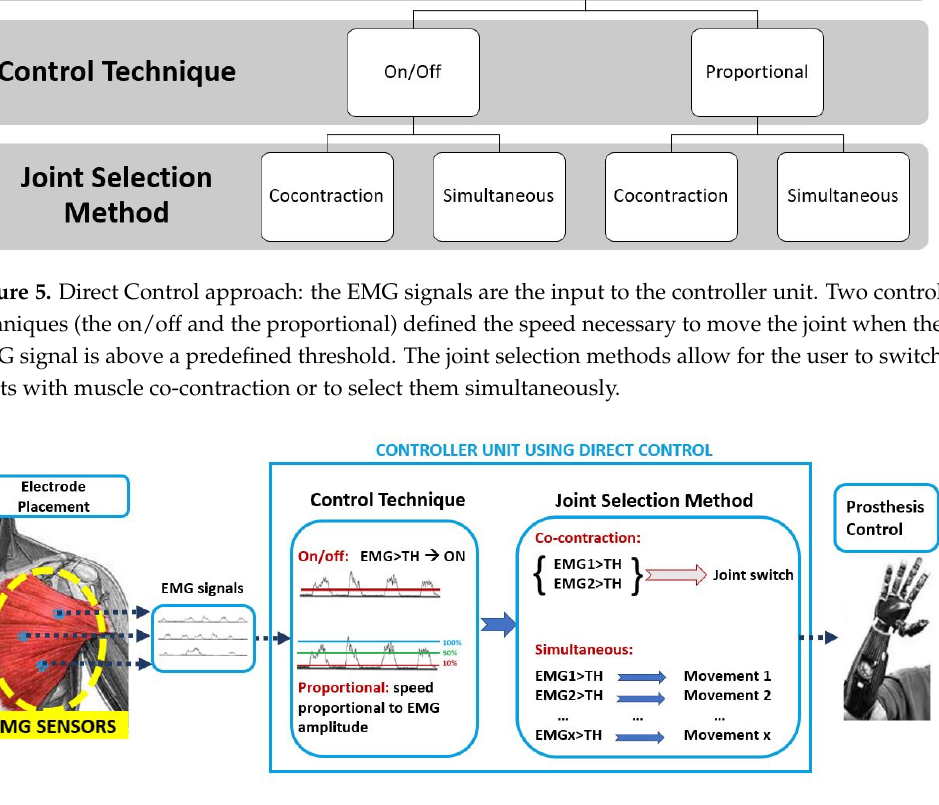
Figure 6. Schematic diagram of direct myoelectric control techniques and joint selection